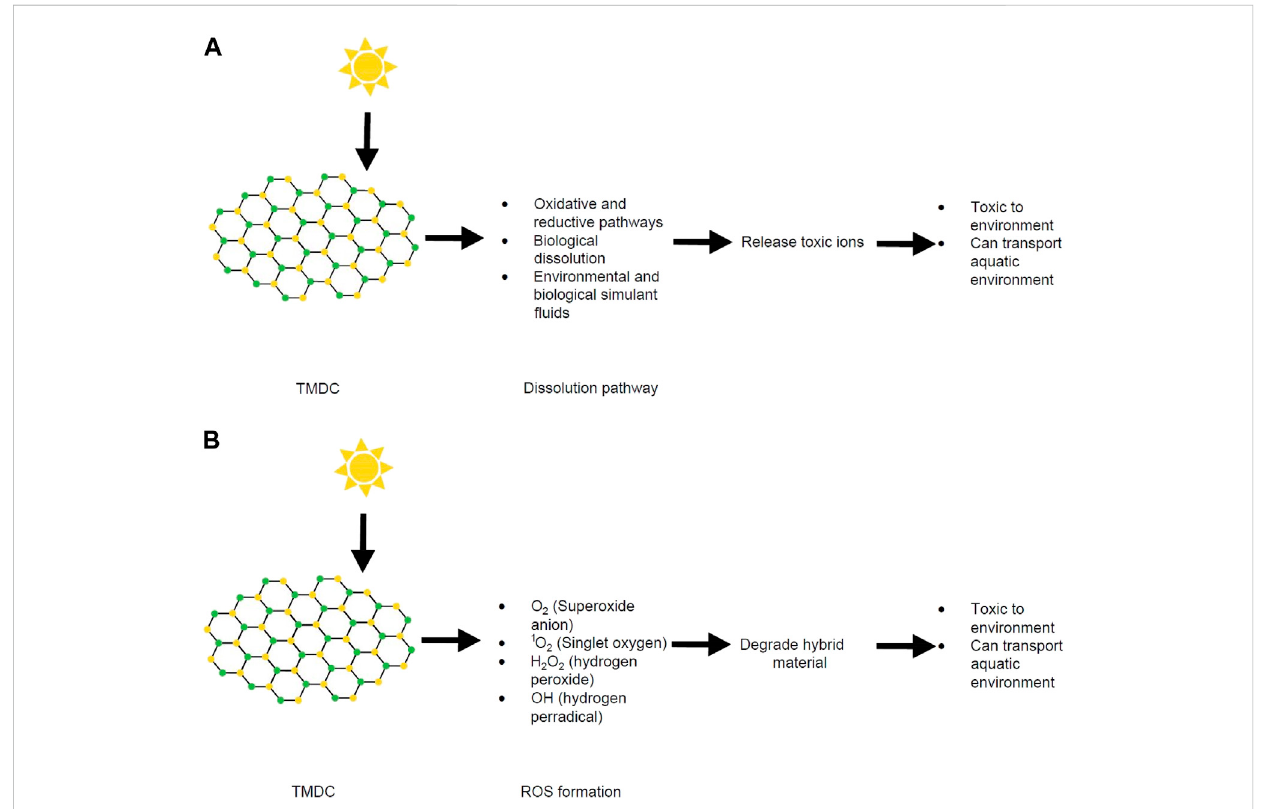
FIGURE 6 (A) Schematic diagram of dissolution process of TMDCs and their fate. (B) Schematic diagram of ROS formation from TMDCs and their fate. Structures produced by AutoCAD